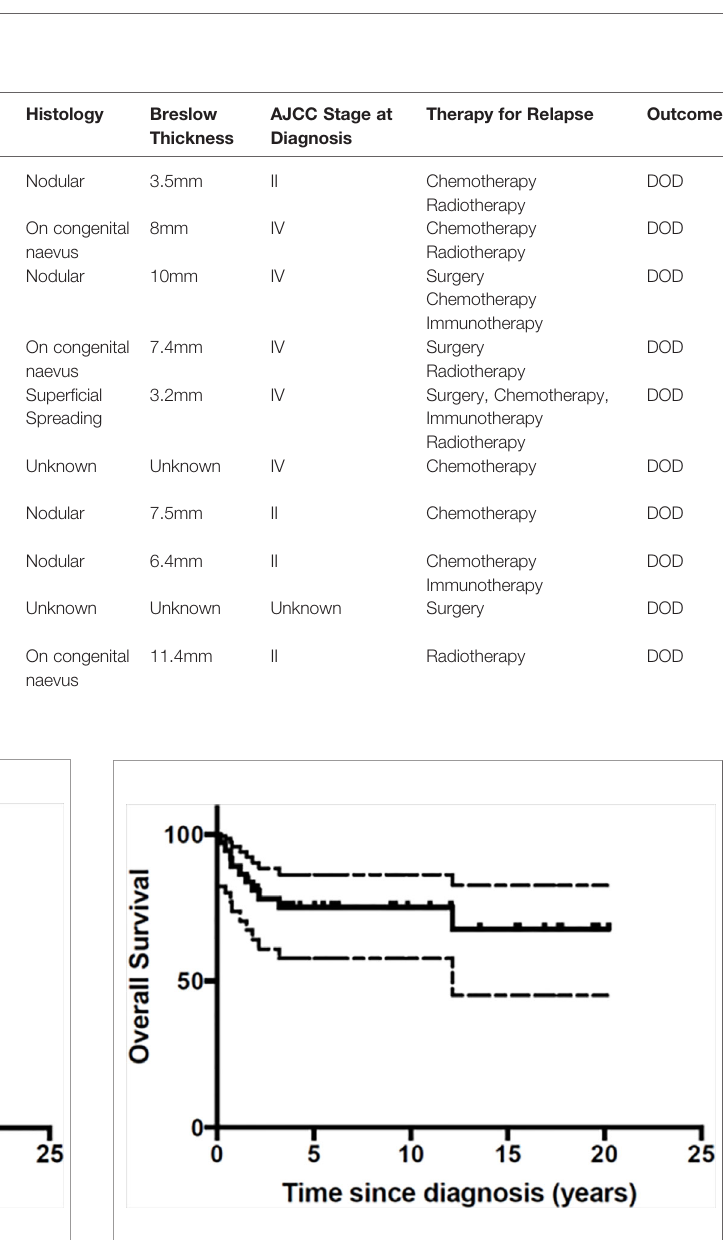
FIGURE 2 | Overall Survival (OS) of the 37 patients with malignant